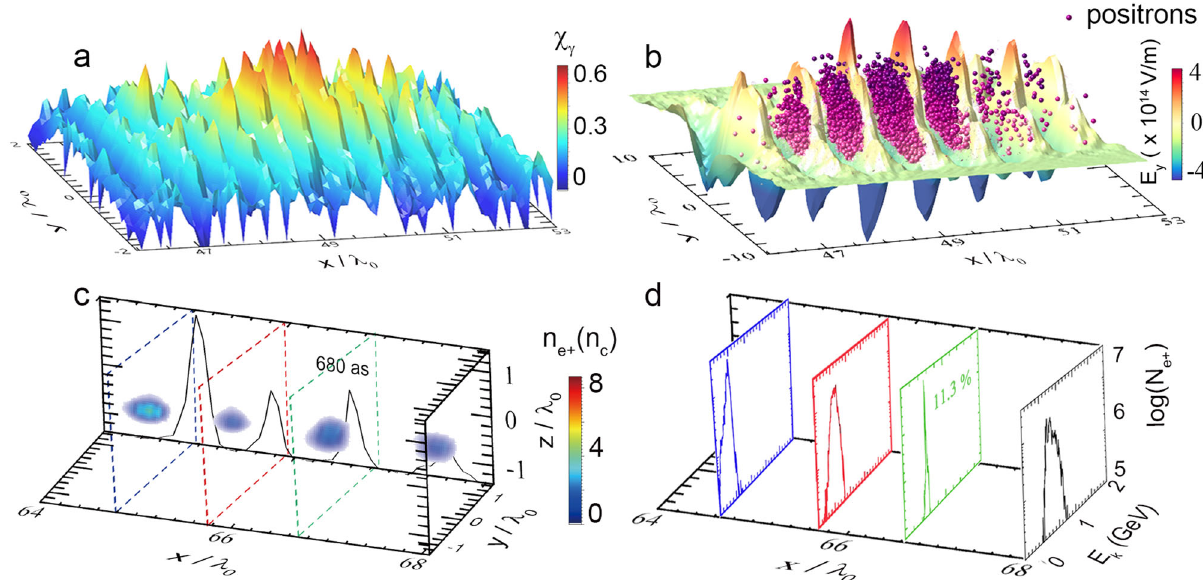
Fig. 4 Quasi-monoenergetic positron bunch generation. a Distribution of quantum invariant χ γ in the collision zone at t = 50 T 0 . b Distribution of positrons and their relative position to the E y fi eld at t = 50 T 0 . c Density distribution of positron bunches at t = 78 T 0 . d The corresponding energy spectrum of each positron bunch as marked in ( c